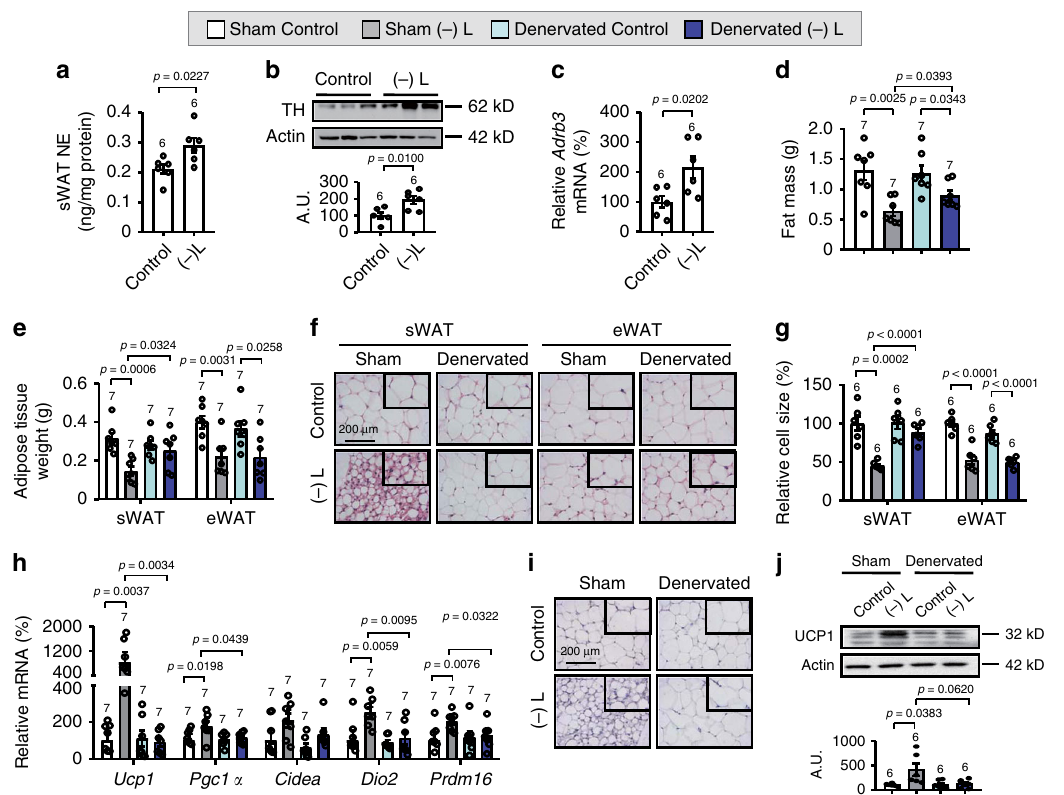
Fig. 6 Sympathetic denervation in sWAT blocks leucine deprivation-induced WAT browning. a Norepinephrine (NE) levels in subcutaneous WAT (sWAT) measured by ELISA kit. b Tyrosine hydroxylase (TH) proteins in sWAT by western blotting (top) and quanti fi ed by densitometric analysis (bottom); A.U.: arbitrary units. c Gene expression of Adrb3 in sWAT by RT-PCR. d Fat mass by NMR. e Adipose tissue weight. f Representative images of hematoxylin and eosin (H&E) staining of sWAT and epididymal WAT (eWAT). g Cell size quanti fi ed by Image J analysis of H&E images. h Gene expression of Ucp1, Pgc1a, Cidea, Dio2 , and Prdm16 in sWAT by RT-PCR. i Representative images of immunohistochemistry (IHC) of UCP1 in sWAT. j UCP1 protein in sWAT by western blotting (top) and quanti fi ed by densitometric analysis (bottom). Studies for a – c were conducted using 14- to 15-week-old male wild-type (WT) mice fed a control (Control) or leucine-de fi cient [(-) L] diet for 3 days; studies for d – j were conducted using 12-week-old male WT mice with sham operated (Sham) or denervated (Denervated) fed a Control or (-) L diet for 3 days. Data are expressed as the mean ± SEM ( n represents number of samples and are indicated above the bar graph), with individual data points. Data were analyzed by two-tailed unpaired Student ’ s t test for a – c , or one-way ANOVA followed by the SNK (Student – Newman – Keuls) test for d – j . Source data are provided as a Source data fi